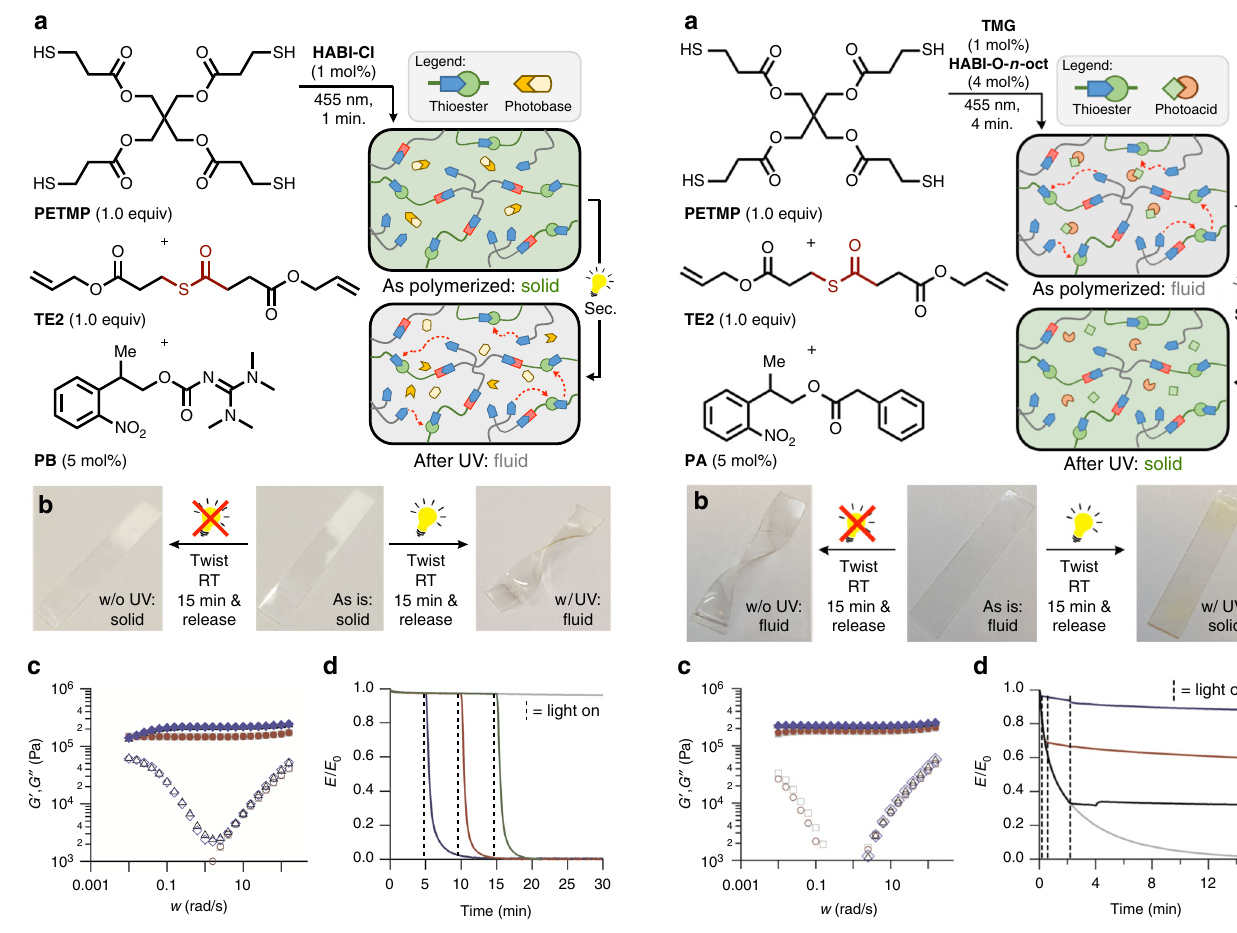
Fig. 2 Permanent, instantaneous switching of a solid to a fl uid. a A general formulation that gives a material which can be switched from a solid to a fl uid with UV light. b As is, the solid sample does not adopt a new shape when twisted; however, after irradiation (5 min, 365 nm, 75 mW/cm 2 ), the now fl uid sample permanently adopted the twisted shape. c Rheometry shows that this material acts as a solid (immediately after polymerization: G ′ = grey fi lled square; G ″ = grey open square; 1.5 h after polymerization: G ′ = red fi lled circle; G ″ = red open circle) until exposure to UV light, which switches it to a fl uid (immediately after UV light: G ′ = black fi lled triangle; G ″ = black open triangle; 1.5 h after UV light: G ′ = blue fi lled diamond; G ″ = blue open diamond). d The nearly instantaneous fl uidization of the network upon exposure to UV light, shown here by the relaxation of stress at a constant strain (10% strain, light on at 5 (blue), 10 (red), and 15 (green) minutes, continuously irradiated, 365 nm, 75 mW/cm 2 ). Grey line — not